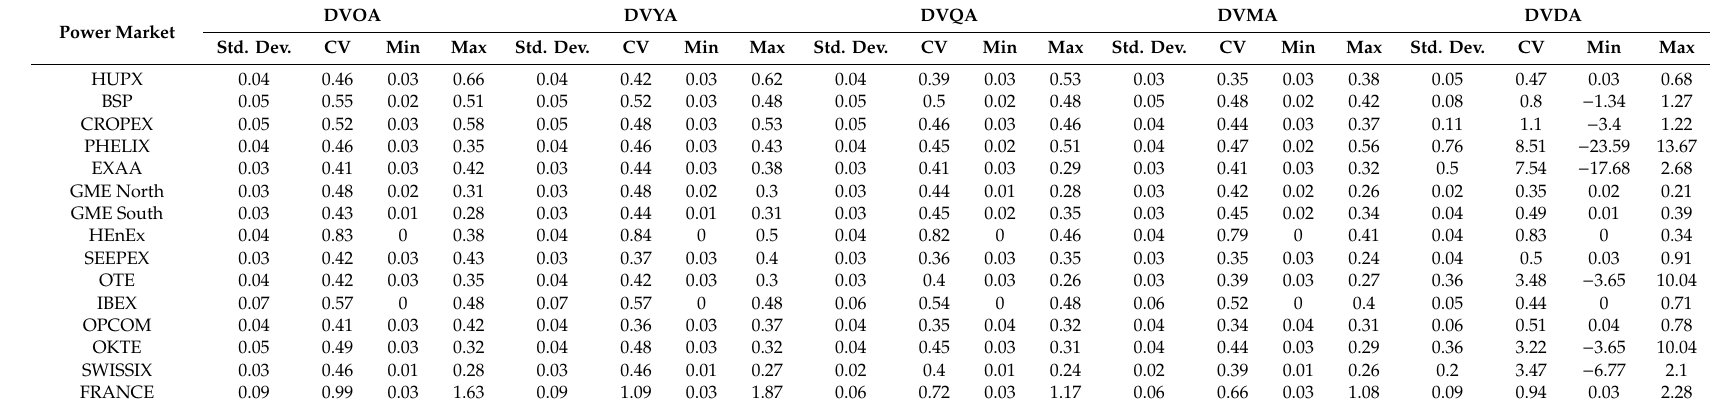
Table 2. Descriptive statistics of power exchanges for DVOA, DVYA, DVQA, DVMA and DVDA.